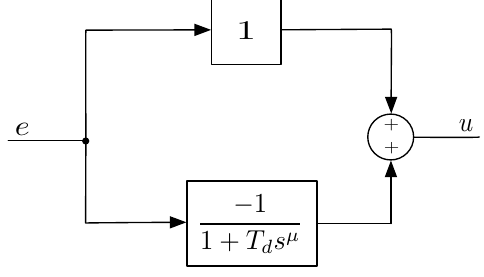
Figure 6. Fractional order derivative action scheme (classical